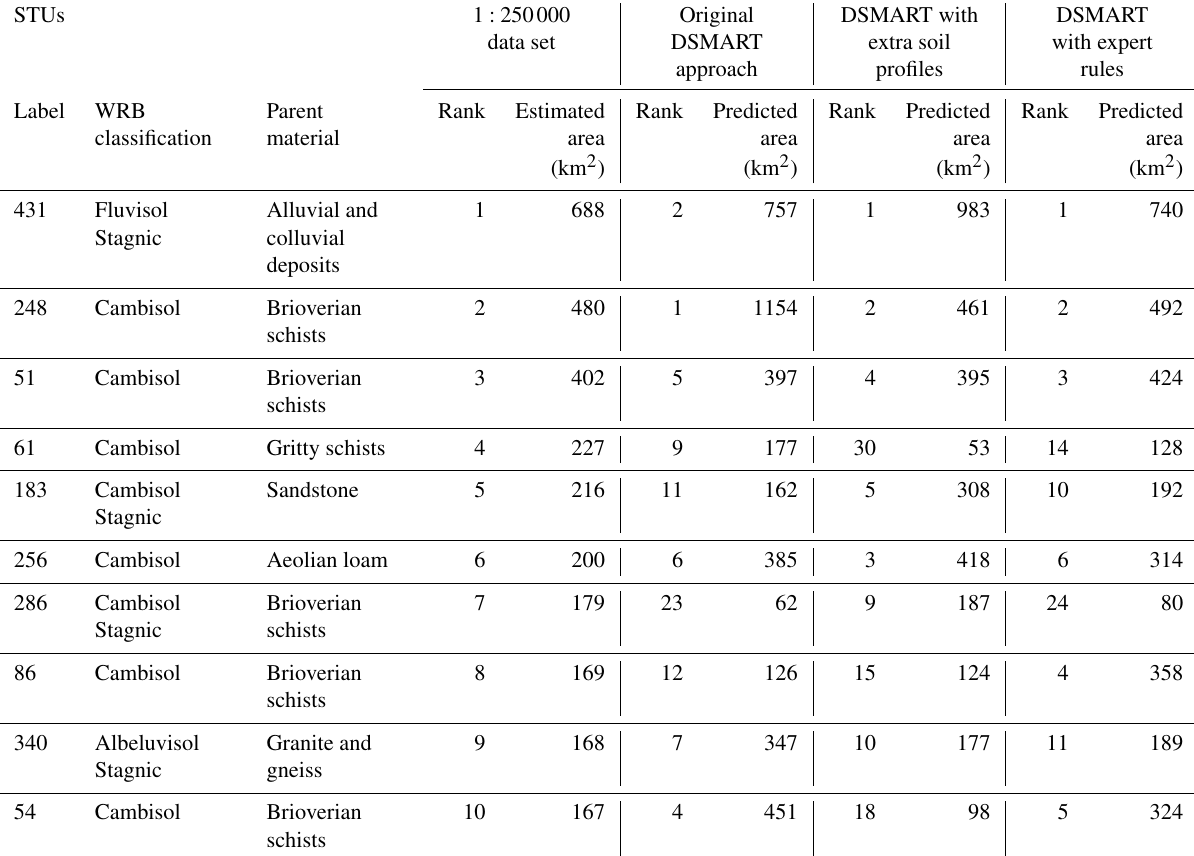
Table 2. The 10 most extended STUs, according to the regional soil database, and their respective rank by area using three DSMART-based disaggregation